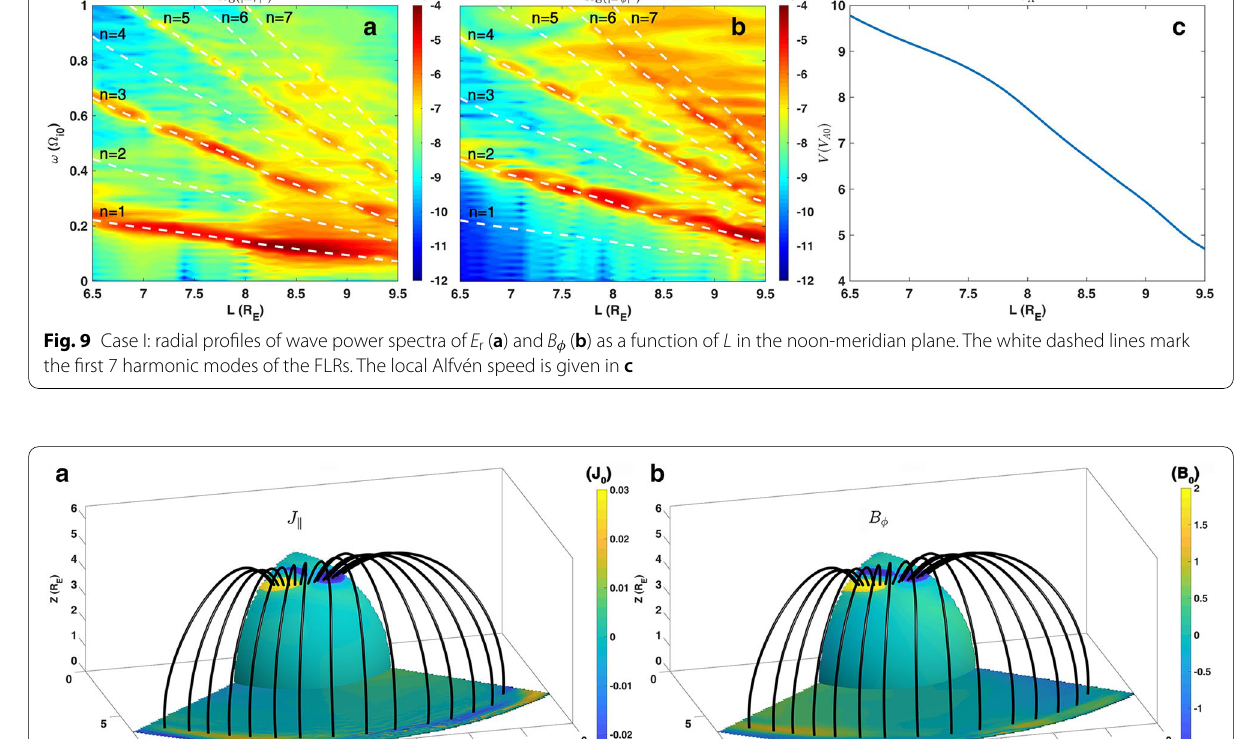
Fig. 10 Case I: global contour views of a J through the strongest FAC